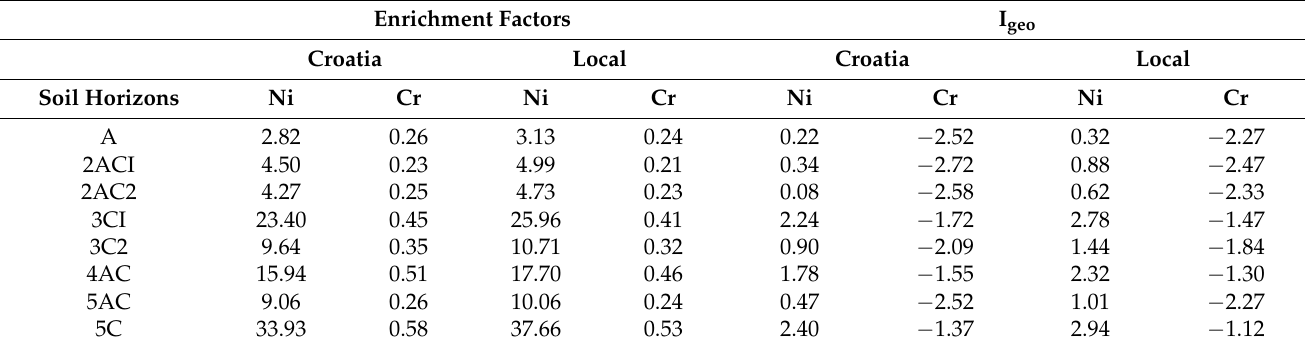
Table 4. Enrichment factors ( EF ) and index of geoaccumulation (I geo ) at local and state level for Ni and Cr in analyzed Fluvisols. Within this research, the median for Cr and Ni at local (Central Croatia) and state scale (Croatia) was used according to [31]. Enrichment Factors I geo Croatia